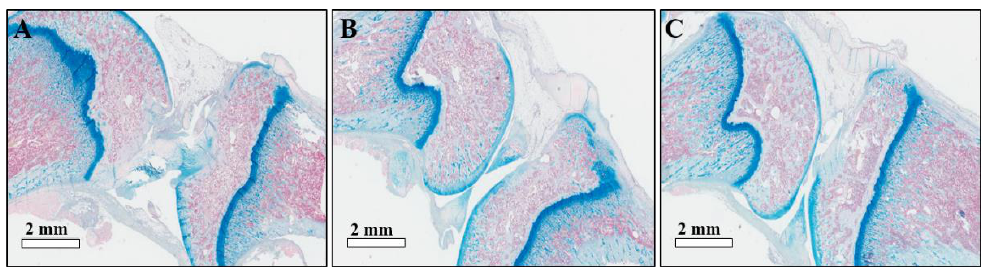
Figure 7 . Histological images of knee joints treated with saline ( A ), Dex ( B ), and Dex-RMSNs ( C ). Tissues were stained with H & E and Alcian blue solution.